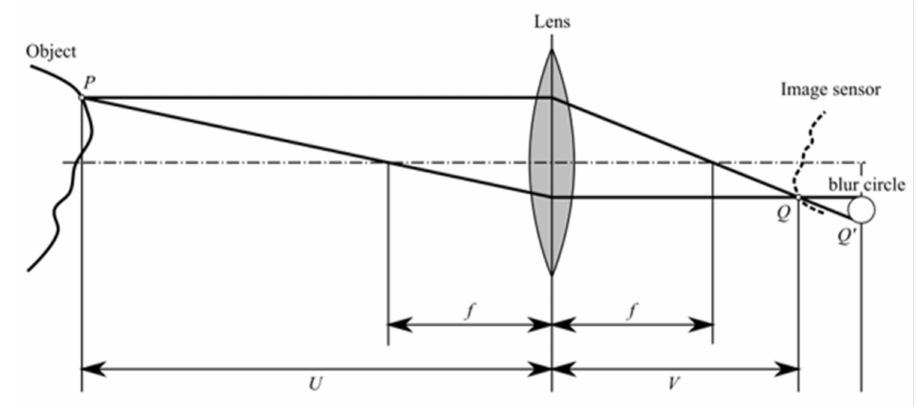
Figure 1. Principles of an optical system.